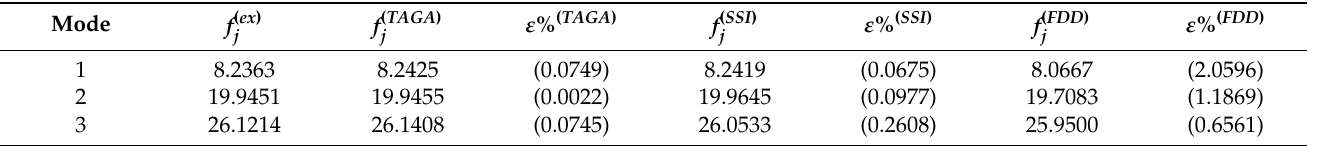
Table 3. Exact frequencies, identified frequencies, and corresponding discrepancies for the 3DoF